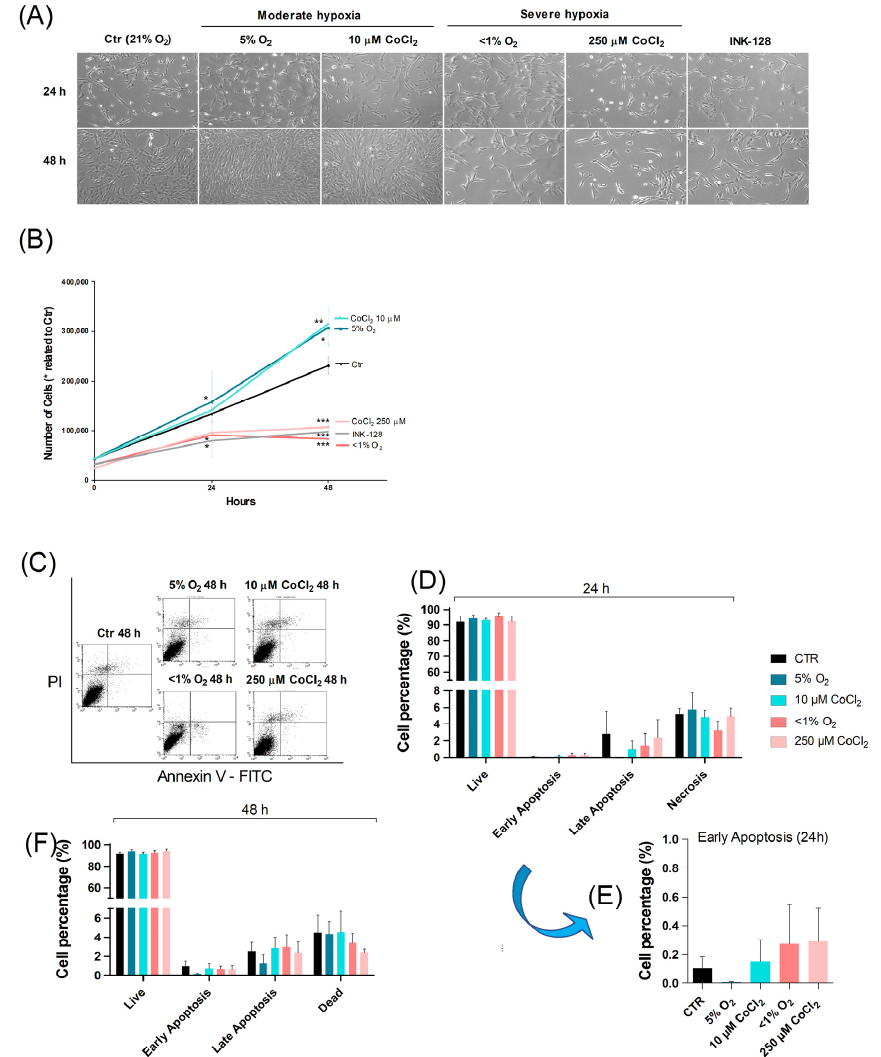
Figure 1. Hypoxic stimuli have opposing effects on UC-MSC proliferation. UC-MSCs were cultured under different O 2 and CoCl 2 levels—control (21% O 2 ), and moderate (5% O 2 and 10 µ M CoCl 2 ) and severe (<1% O 2 and 250 µ M CoCl 2 ) hypoxia—and cultured with INK-128, for 24 and 48 h. ( A ) Representative images of plated UC-MSCs treated under control and experimental conditions, captured in a phase-contrast microscope (10 × magnification). ( B ) Total number of live cells counted after 24 and 48 h incubation period, under control and experimental conditions, from a minimum of 3 independent experiments. Results are represented as means with SEM. Statistical significance considered when * p < 0.05%, ** p < 0.01 and *** p < 0.001. ( C ) Representative flow cytometry dot plot and the respective 24 h ( D ) and 48 h ( F ) quantification of live, early apoptotic, late apoptotic, and necrotic populations through Annexin V/PI staining. ( E ) Enhanced scale of the early apoptosis bars of graph